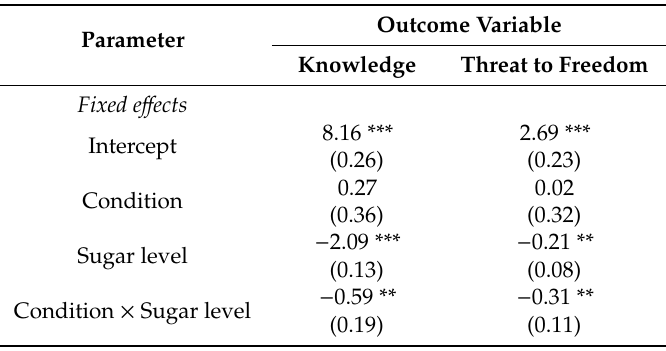
Table 3. Parameter estimates of the e ff ects of sugar level and condition on knowledge and threat to freedom, using linear mixed-e ff ect model